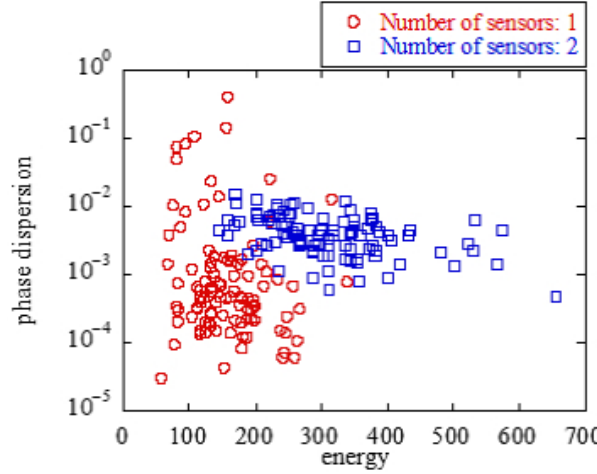
Figure 9. w/o antenna